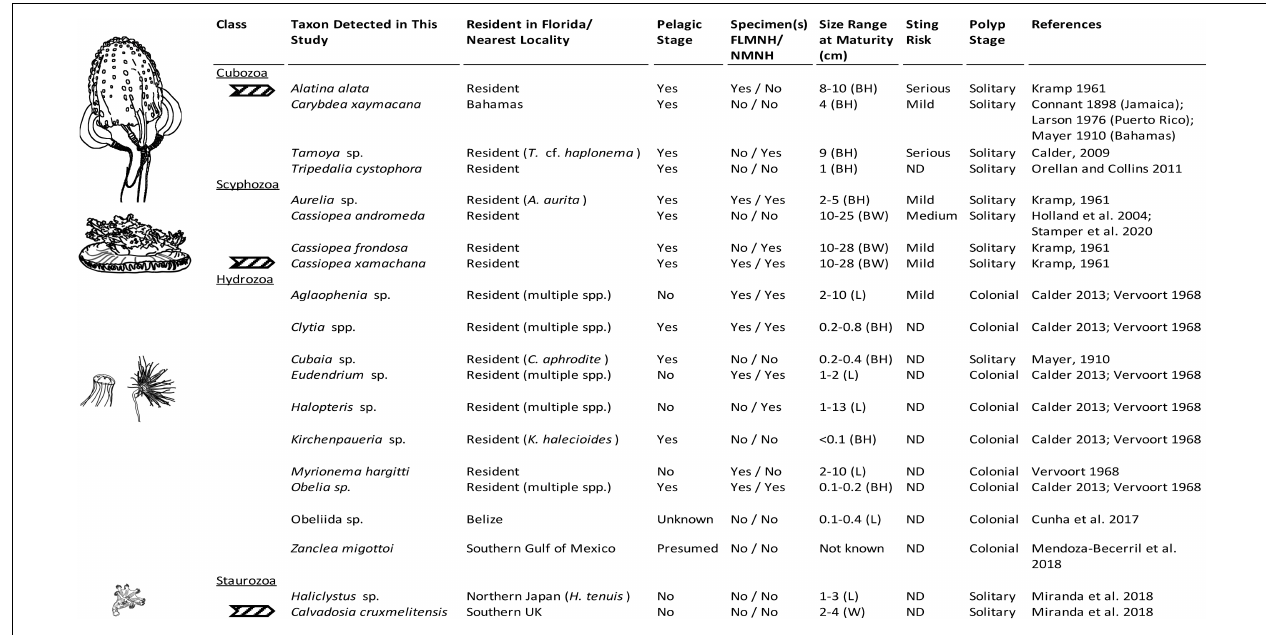
FIGURE 7 | Medusozoa fauna identified from 16S rRNA gene using FeDS. The table highlights morphological characteristics and residency in the Florida Keys sampling areas or closest geographic location. Line drawings to the left depict a representative taxon for each class, drawn in comparative scale. Arrows indicate species for which partially annotated genomes have been published (Ohdera et al., 2019). BH, bell height; BW, bell width; L, length of hydroid; W, width; ND, no data available; FLMNH, Florida Museum of Natural History; NMNH, National Museum of Natural History, Smithsonian Institution.